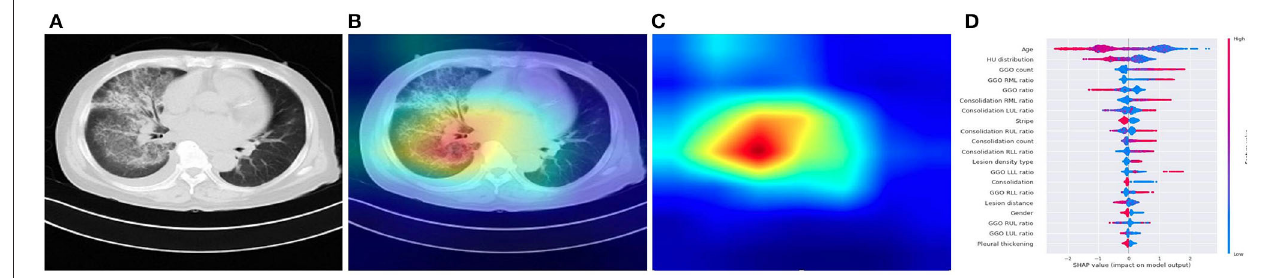
FIGURE 4 | Illustration of characteristics that contribute to the prediction of pneumonia using CAM and SHAP. (A) A COVID-19 patient’s origin image sample. (B,C) Visualize the attention regions of a network for distinct abnormality and disease categories. (D) The relative contribution of each CT or clinical measure to predicting the probability of pneumonia prediction. Features to the right of the risk explanation bar increased the danger, while features on the left decreased